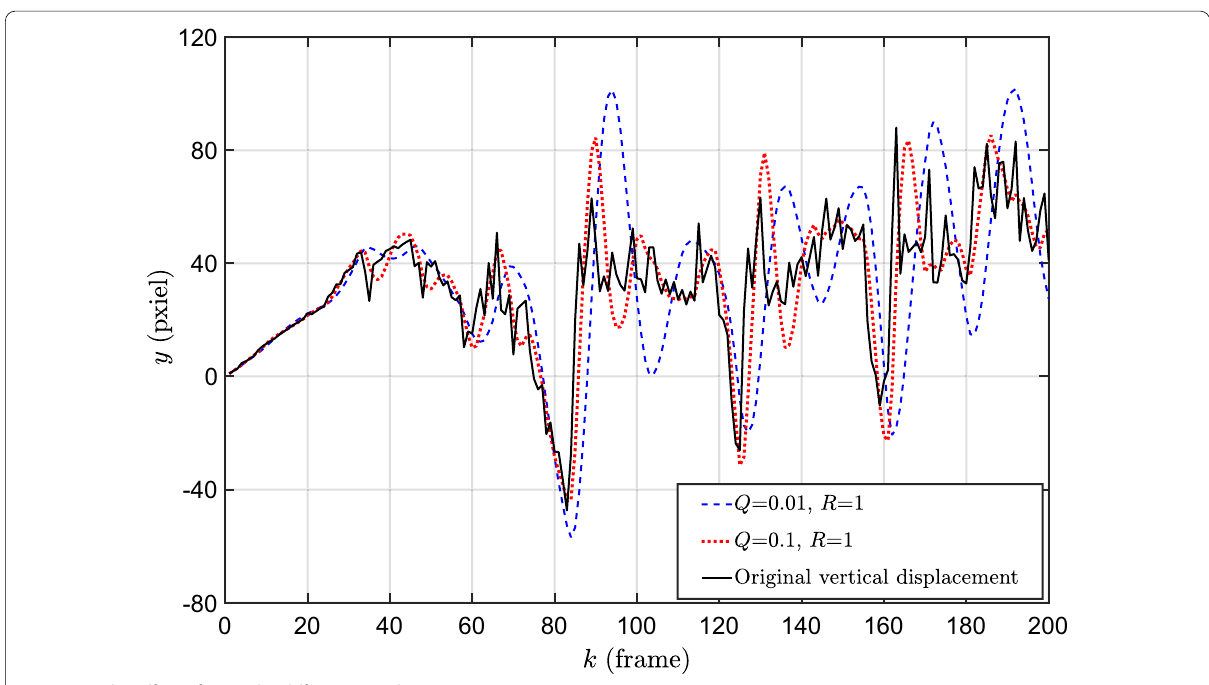
Figure 4 The effect of KF under different Q and